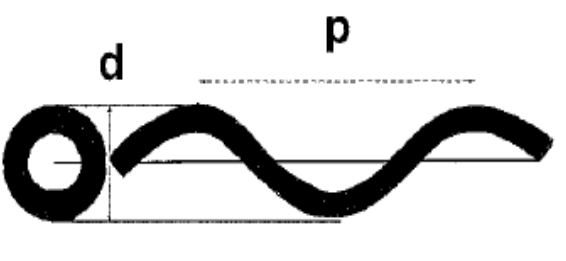
Figure 1. Coiled tube with its projection (left) showing d ) helix diameter and p ) coil pitch. Reproduced from [25] with